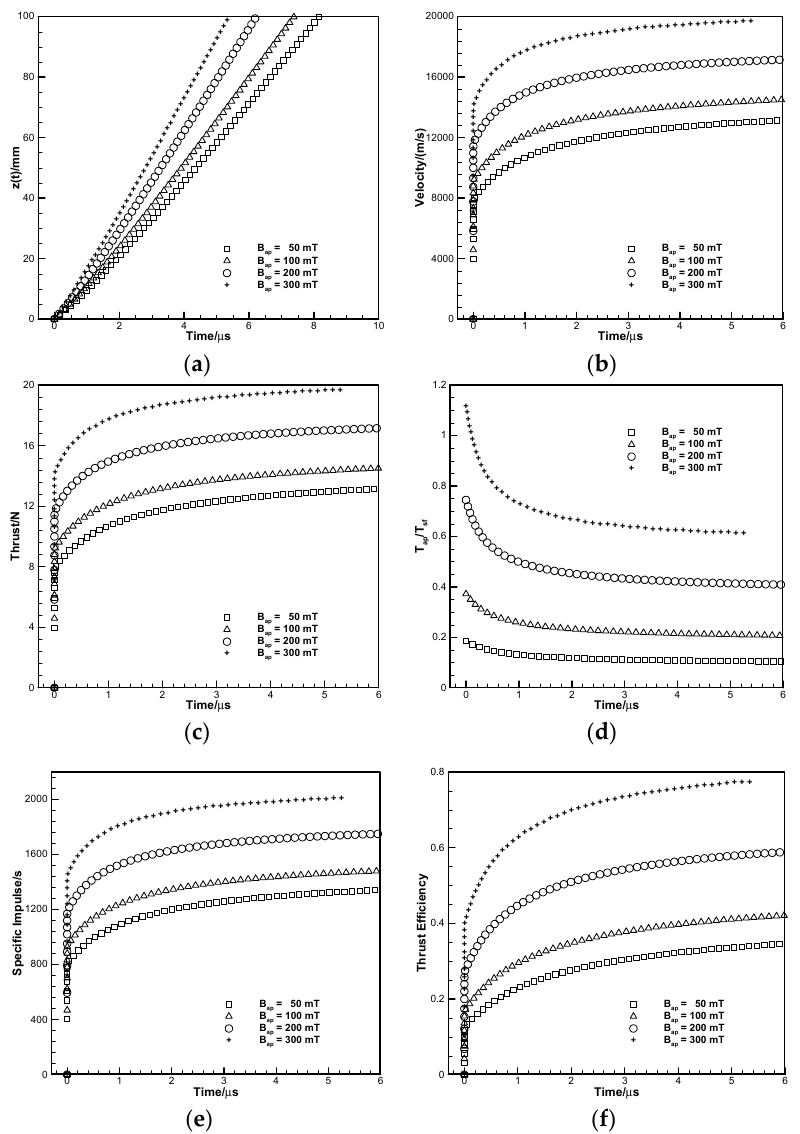
Figure 11. Effects of applied magnetic field strength on thrust performances: ( a ) Axial movement of current sheet; ( b ) Velocity of current sheet; ( c ) Thrust; ( d ) Ratio of applied-field thrust to self-field thrust; ( e ) Specific impulse; ( f ) Thrust efficiency.